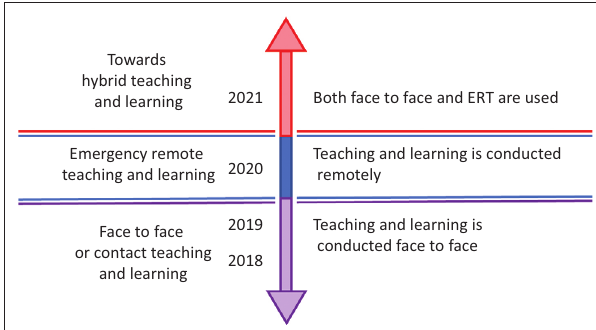
FIGURE 1: South African academic institution timelines as related to teaching and